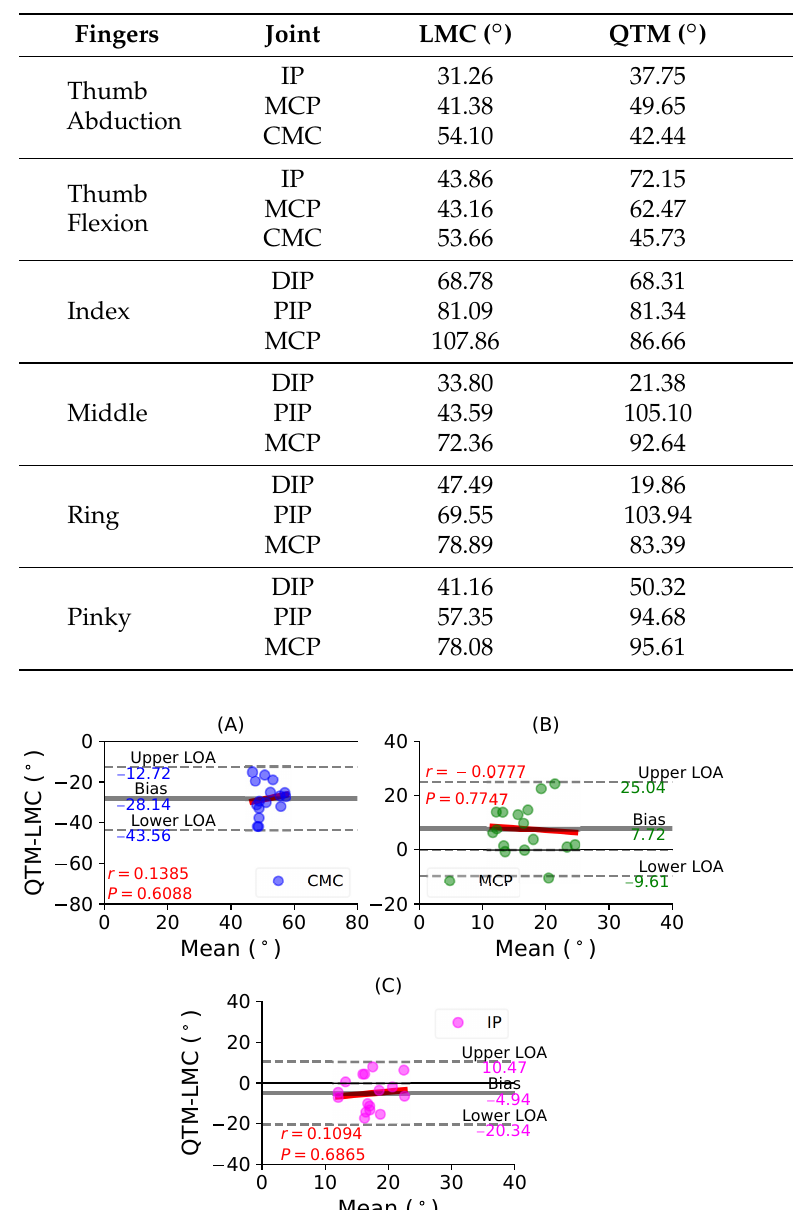
Table 2. Functional range of motion of the fingers at every joint for all trials.